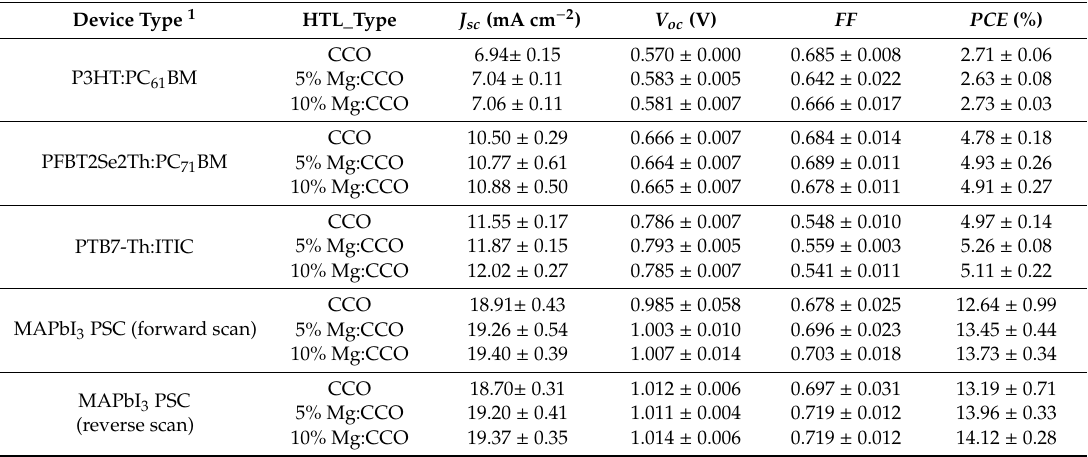
Table 4. The device parameters of OSCs and MAPbI 3 PSCs with CCO, 5% Mg:CCO, and 10% Mg:CCO